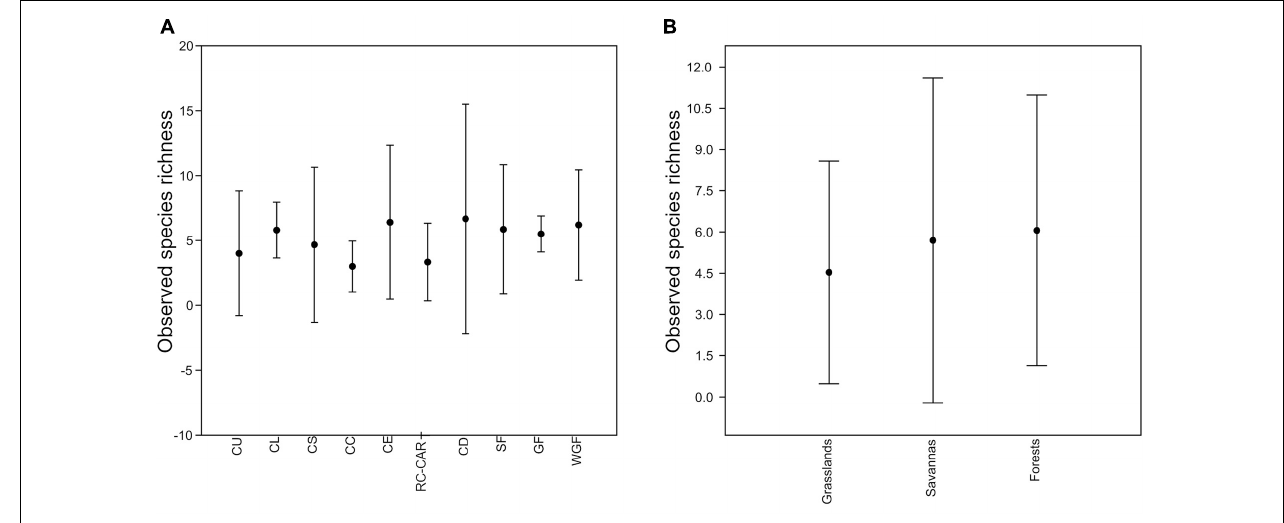
FIGURE 4 | Mean observed species richness across the different habitats (A) and the three main habitat types (B) based on the 45 sites surveyed within the Cerrado. Point = mean, lines = SD, CU = “campo úmido,” CL = “campo limpo,” CS = “campo sujo,” CC = “campo cerrado,” CE = “cerrado sensu stricto, ”